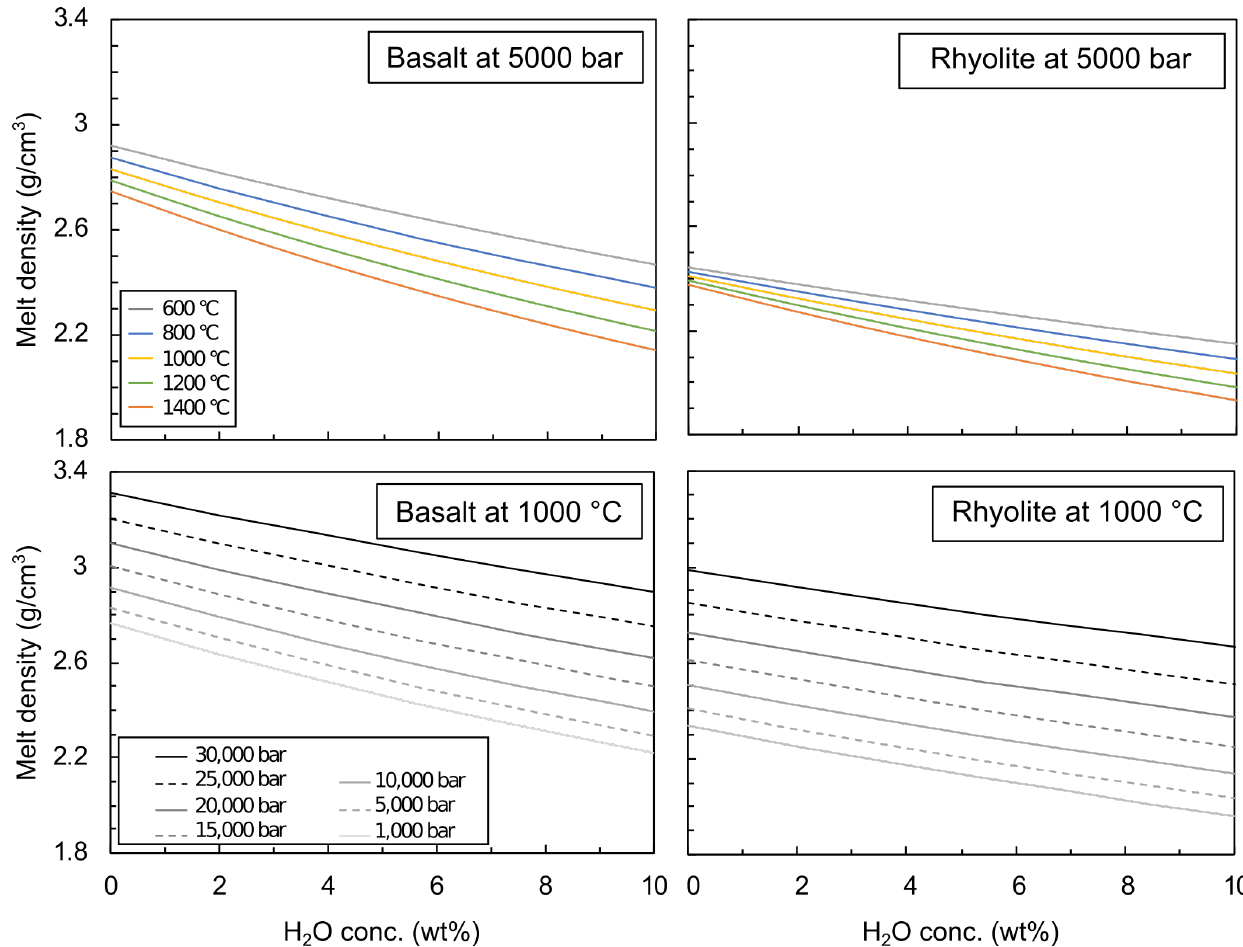
Figure 2: The e ff ect of pressure and temperature on the density of basaltic and rhyolitic melt. Anhydrous basalt composition: sample TT152-21-35 as reported in Dixon et al. [1995] using an Fe #7 ( op cit. ). Anhydrous rhyolite composition: Bishop Tu ff sample BT87-2 [Wallace et al. 1999] using an Fe